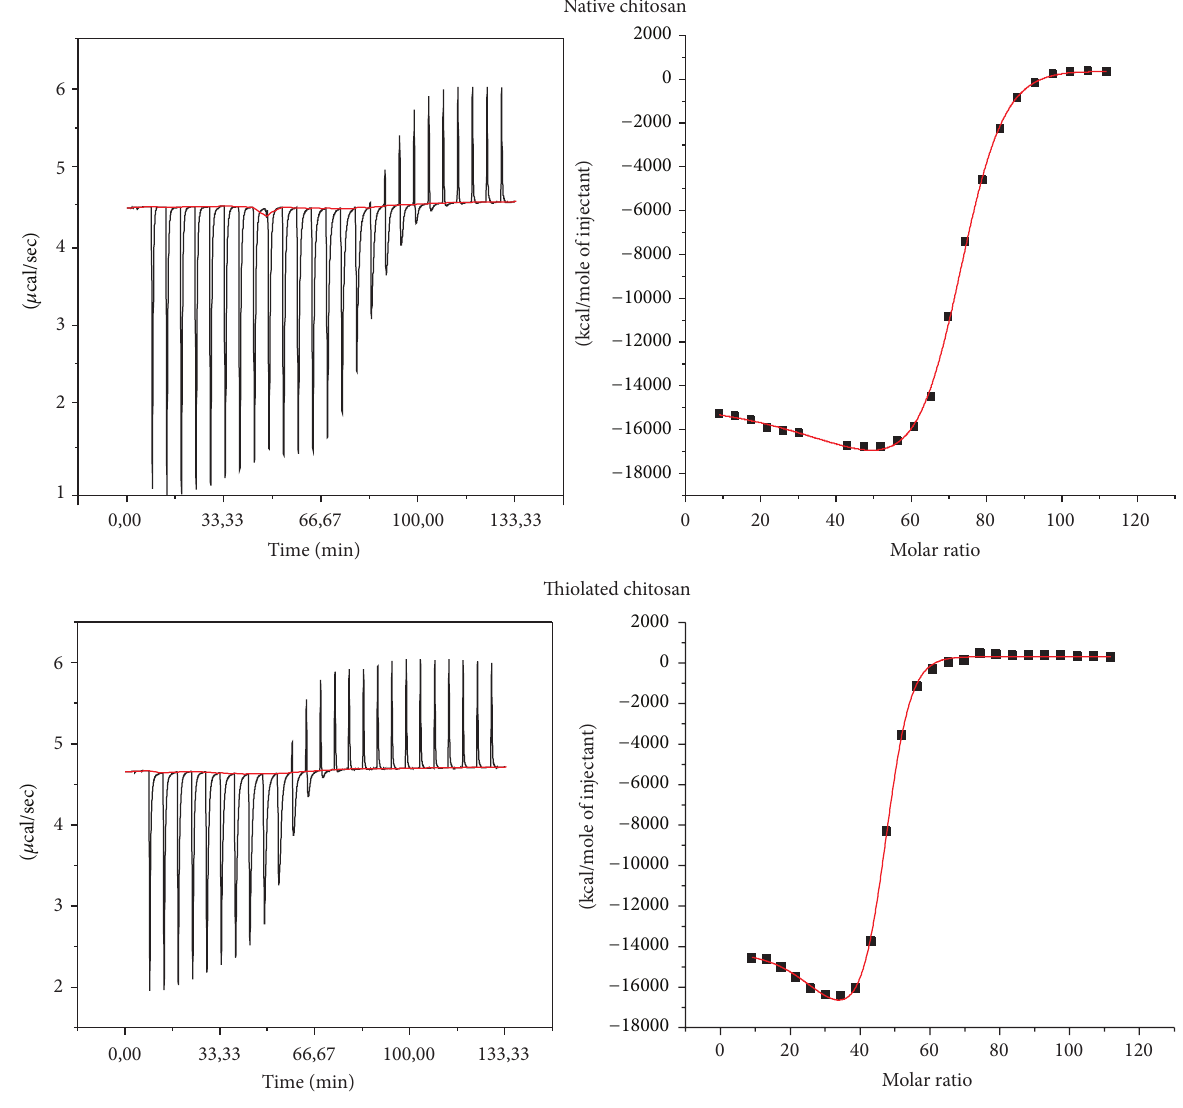
Figure 10: ITC and raw data of thiolated